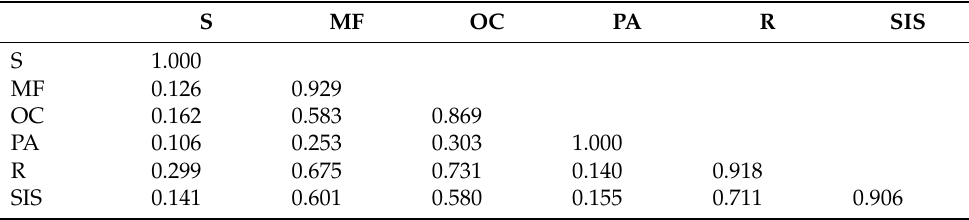
Table 11. Discriminant validity using the Fornell and Larcker criterion.